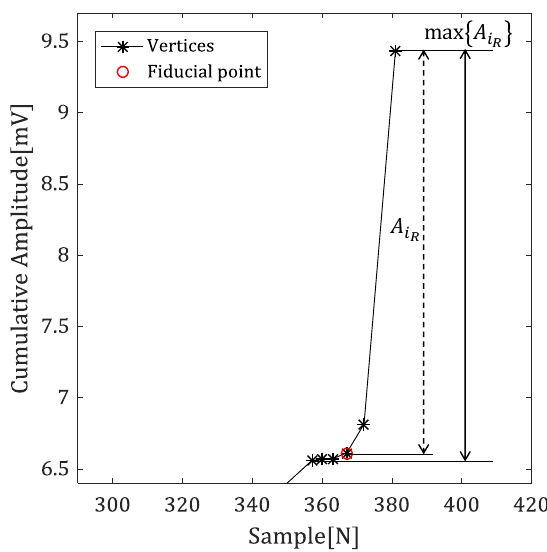
Figure 6. The amplitude difference between R-peak and the vertex in the cumulative